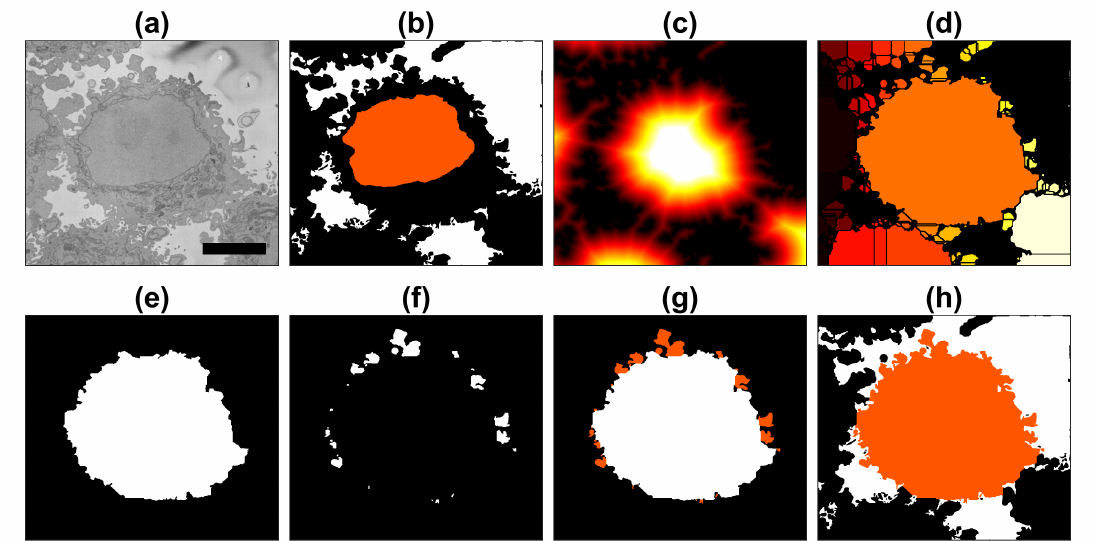
Figure 4. Illustration of the steps of the segmentation algorithm for a cell from neighbouring cells. ( a ) Region Of Interest (ROI) that contains one HeLa cell surrounded by background and other cells. ( b ) The algorithm starts with the nuclear region and background. ( c ) Distance transform from the background. ( d ) Watershed transformation on the distance transform; all regions in the background were removed. ( e ) Central region from the watershed. ( f ) Small regions that were contiguous to the central region. ( g ) Addition of small regions, i.e., membrane protuberances. ( h ) Final result of the cell with the background in white and neighbouring cells in black. A 5 µ m scale bar is shown in ( a